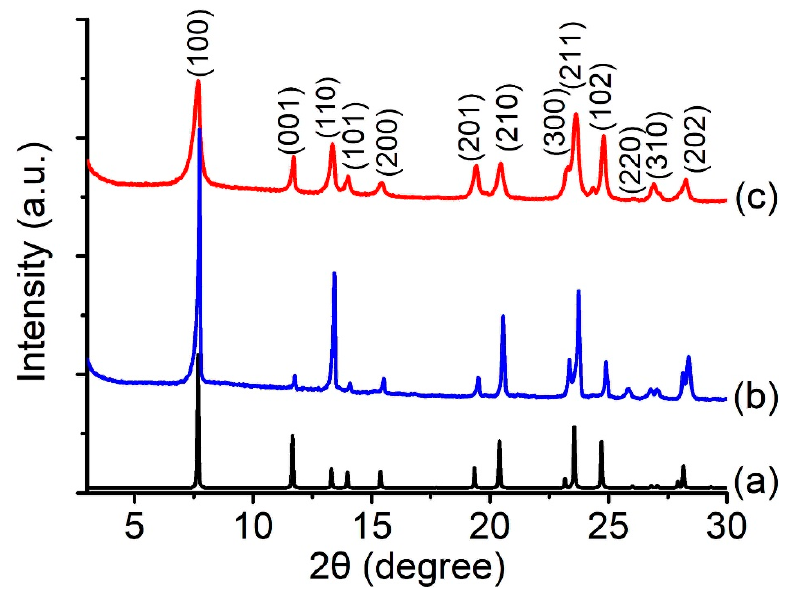
Figure 1. XRD patterns of ( a ) offretite (simulated pattern), ( b ) cetyltrimethylammonium (CTA + )- offretite and ( c ) tetramethylammonium (TMA + )-offretite zeolites.